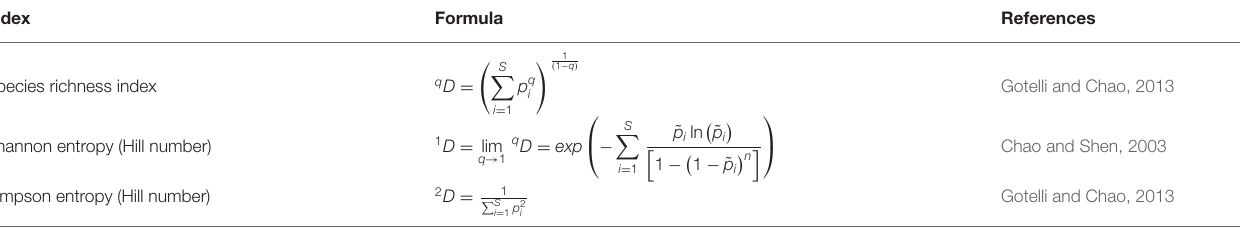
TABLE 1 | Formulas of species richness index and diversity index used in each plant life